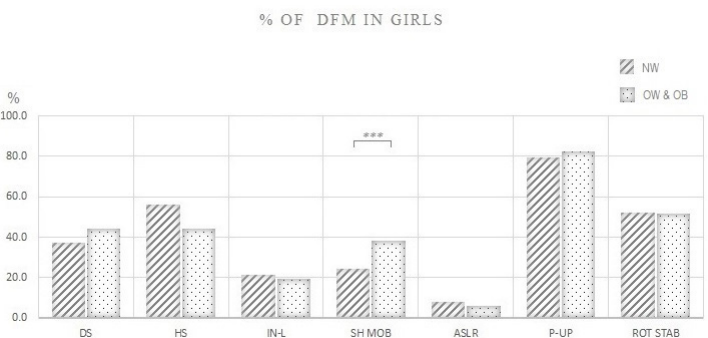
Figure 3. Proportion (%) of girls with normal weight and girls with overweight and obesity that performed dysfunctional movement (DFM) in each FMS test. Note: % OF DFM IN GIRLS: Proportion (%) of girls that performed dysfunctional movement; NW: Girls with normal weight; OW & OB: Girls with overweight and obesity; DS: Deep squat; HS: Hurdle step; IN-L: Inline lunge; ASLR: Active straight leg raise; SHO MOB: Shoulder mobility; P-UP-: Trunk stability push-up; ROT STAB: Rotary stability. *** p =